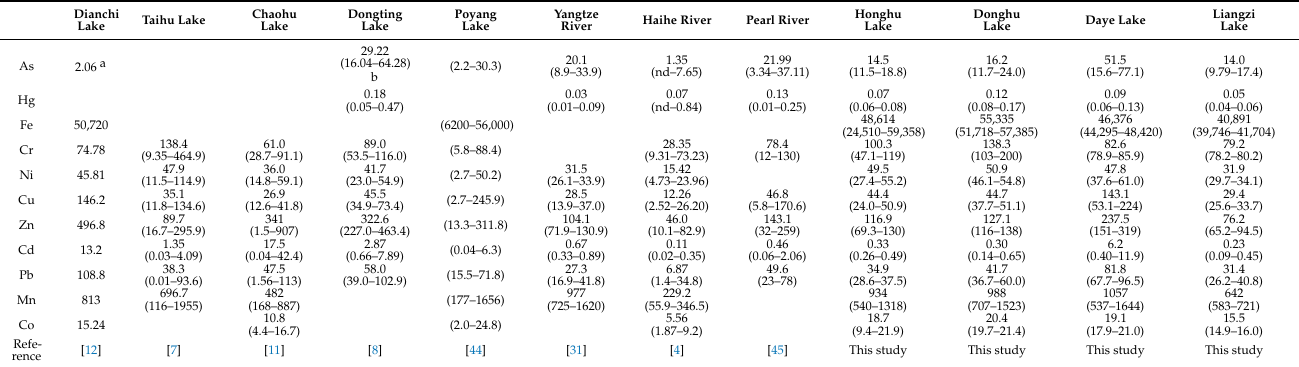
Table 3. Comparison of heavy metals in sediment cores from Honghu Lake, Daye Lake, Liangzi Lake, and East Lake with other surface sediments in China (mg/kg, dry